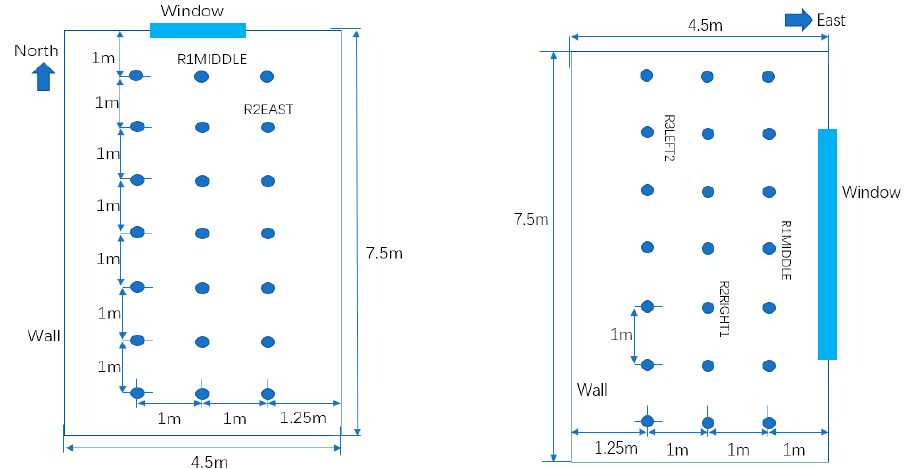
Figure 9. The distribution of optional sensor locations in the north-facing room and east-facing room.